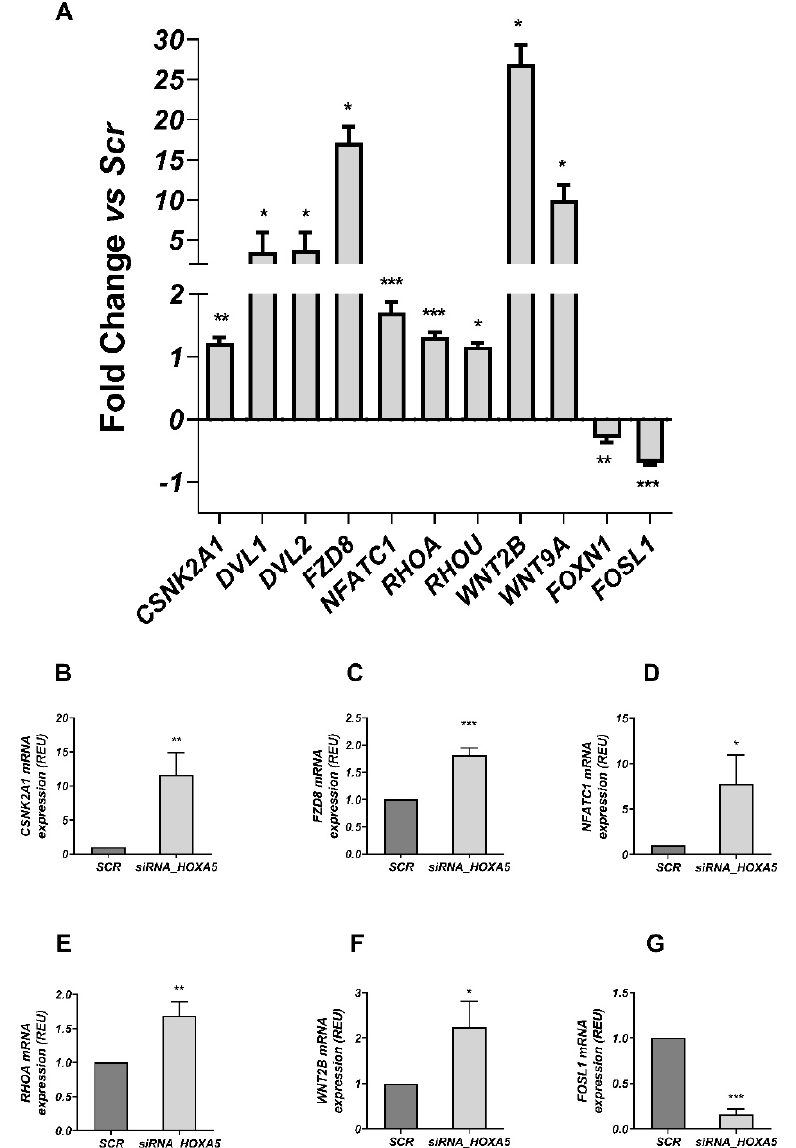
Figure 3. Differential expression of genes embedded in the WNT-signaling pathway in human preadipocytes upon HOXA5 silencing (PCR array PAHS-043ZD). ( A ) Eighty-four WNT-related genes were analyzed using the RT2 Profiler™ PCR Array (n = 3 per group/condition). The expression of 11 genes changed significantly in the HOXA5 -silenced preadipocytes compared to cells transfected with scrambled siRNA (SCR). Data analyses were performed using web-based analysis software as described in the Materials and Methods. Data are presented as a fold-change relative to scramble ‐ treated cells. Levels of significance were section: * p < 0.05; ** p < 0.01; *** p < 0.001. The 11 differentially expressed genes, identified by the RT2 Profiler™ PCR array, were individually ana ‐ lyzed by qPCR in the same samples also tested in the PCR array (n = 3 per group/condition). ( B – G )